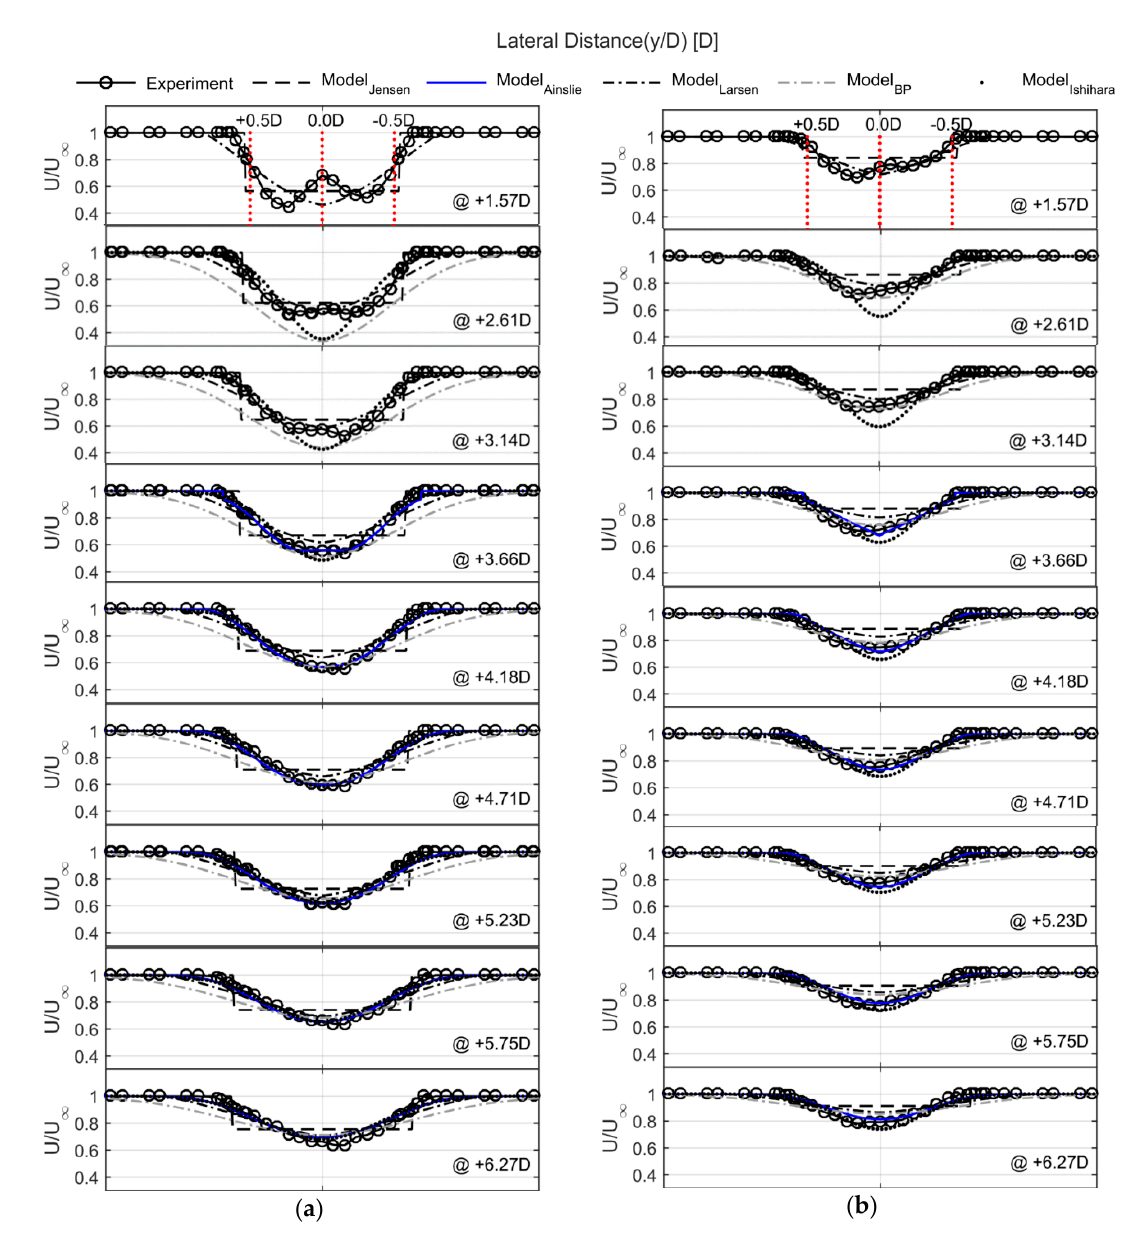
Figure 7. Comparison of the normalized wind profile with the downstream distance with the revised Ainslie eddy viscosity wake model: ( a ) below rated case ( C T = 0.8); ( b ) above rated case ( C T = 0.36).